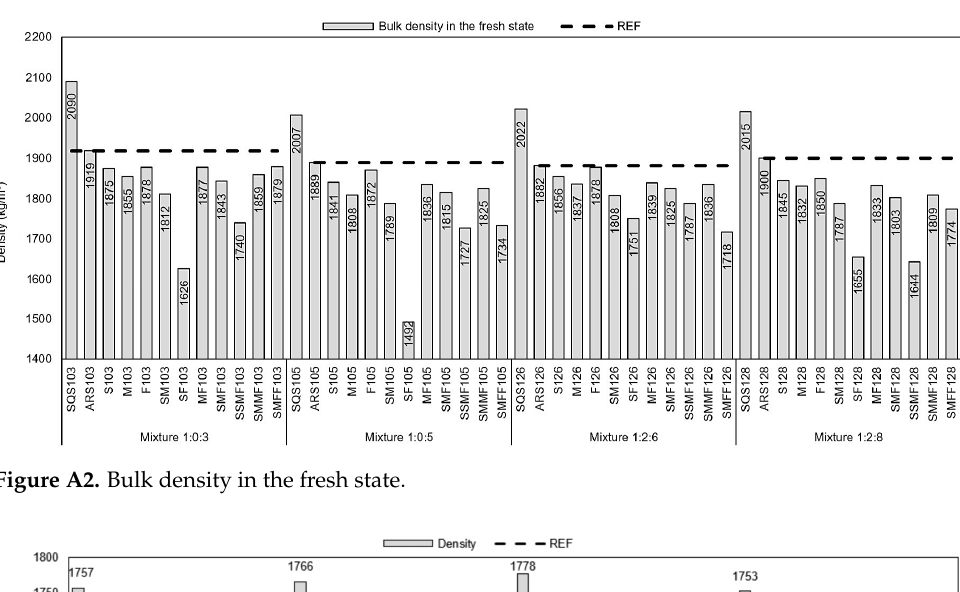
Figure A1. Water/solid ratio and water/binder ratio.